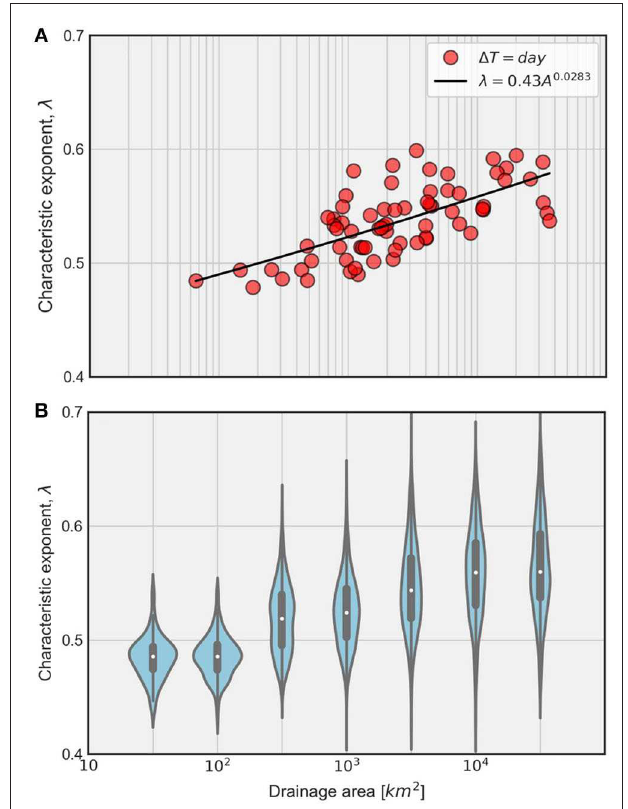
FIGURE 11 | Spatial dependence of λ . (A) Expected value of λ over the years across stations. The solid dark line corresponds to the power-law model fit to the data. The relationship between expected value of λ and drainage area is statistically significant. (B) Distribution of λ over the years considering pooled data from consecutive windows of basin scales. Clearly, the size of drainage area affects the resulting processes. The larger the basin scales, the longer the persistent behavior of